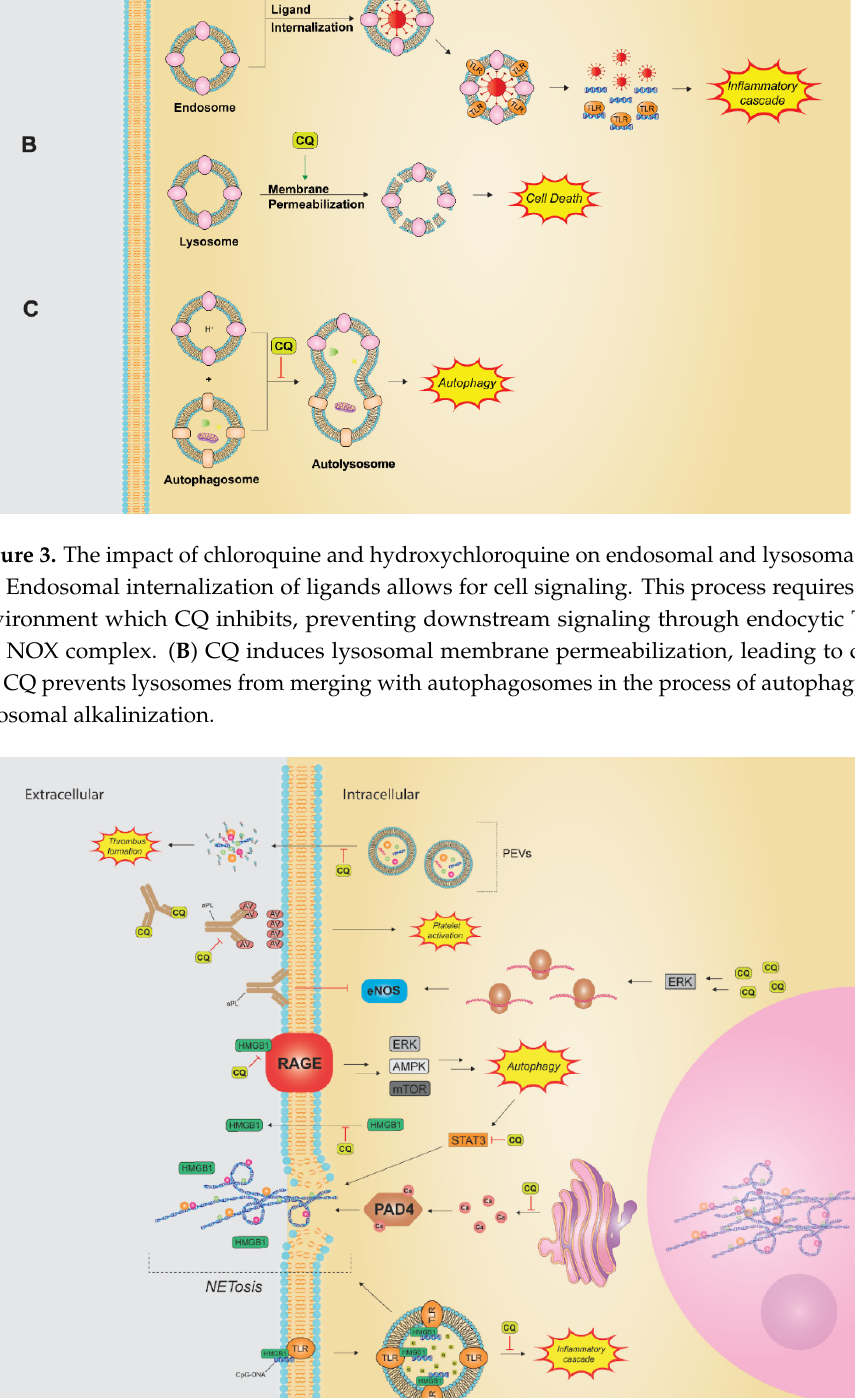
Figure 4. Inhibition of thrombus formation and NETosis. Thrombus formation driven by platelet- derived extracellular vesicles (PEVs) and antibody-induced platelet activation is inhibited by CQ. CQ also has a complex interference with NETosis, shown in the figure via inhibition of RAGE-mediated autophagy, HMGB1 release, and activation of PAD4, NOX, and TLRs.